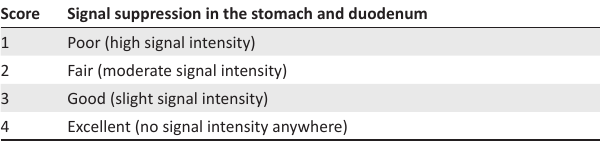
FIGURE 2: This maximum intensity projection coronal reconstruction magnetic resonance cholangiopancreatography image demonstrates a significant reduction in the signal intensity of the duodenum from high to moderate signal intensity ( Δ maximum ROI 2230 → 2192): (a) pre-contrast magnetic resonance cholangiopancreatography; (b) post-contrast magnetic resonance cholangiopancreatography. Correspondingly, visualisation of the common bile duct (CBD) improved from fair to excellent, and visualisation of the main pancreatic duct (MPD) improved from good to TABLE 1: Perception of signal intensity in the stomach and duodenum.